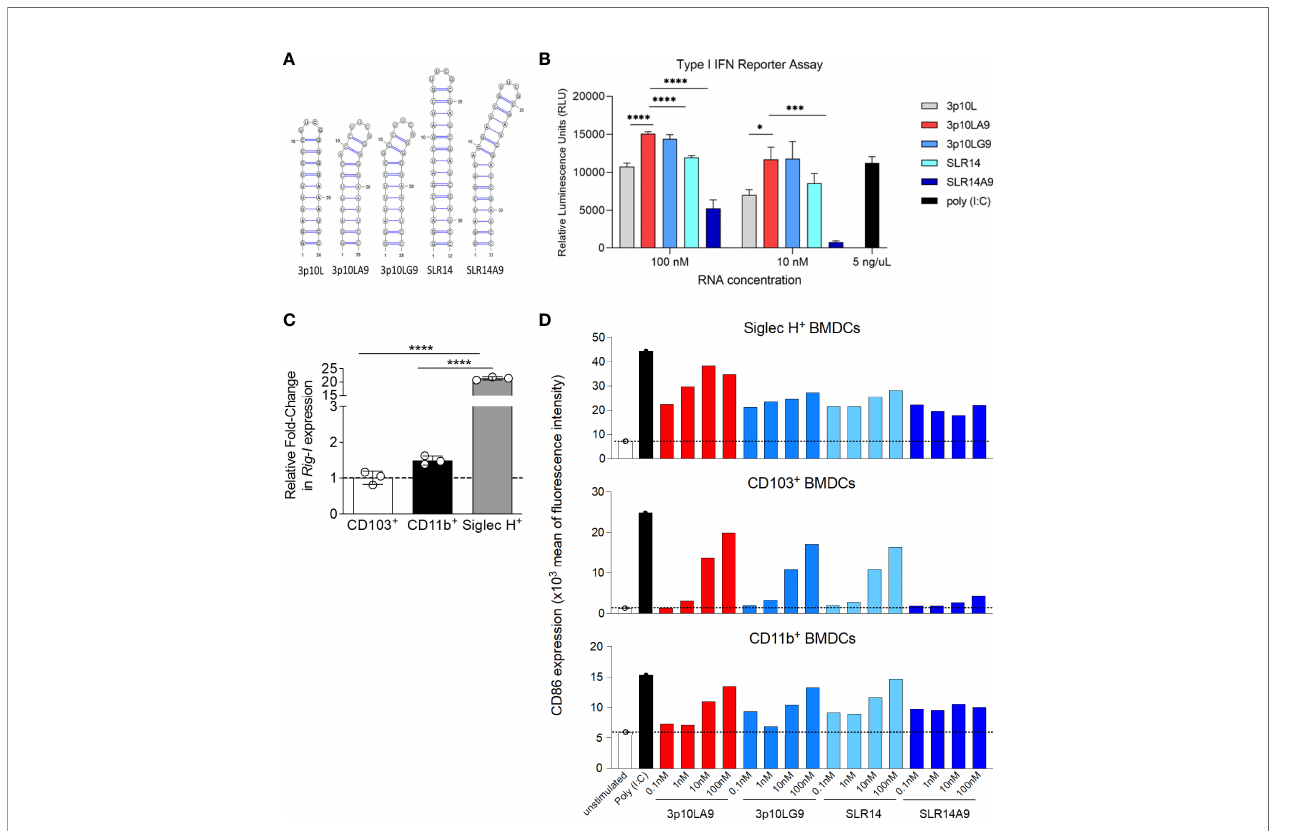
FIGURE 1 | BM-derived DC maturation is induced by dsRNA hairpins (A) Sequence and secondary structure of the dsRNA hairpins used in this study. (B) Type I IFN related relative luminescence units (RLU) of A549-Dual ™ supernatant at 24h post dsRNA hairpin treatment. Poly (I:C) treatment (5 ng/µL) as positive control (n = 3). * P < 0.05; *** P <0.001;**** P < 0.0001; two-tailed t-Student ’ s Test. These data are representative of three independent experiments. (C) Quantitative PCR analysis of RIG-I expression in BM-derived sorted pDCs, CD103 + and CD11b + DCs. Data represent the mean ± SEM (n = 3). (D) BMDCs were stimulated with 4 different concentrations (0.1 – 100 nM) of dsRNA hairpins (3p10LA9, 3p10LG9, SLR14 and SLR14 A9) and tested 24 h later for CD86 expression by fl ow cytometry. BM cells were fi rst gated on Siglec H + cells to visualize pDCs, the remaining cells were gated on CD11c + MHC II + double positive cells and separated into CD11b and CD103 to delineate two different DC subsets. Unstimulated and Poly I:C (5 m g/ml) stimulated cells were included as negative and positive controls, respectively. Each bar represents one value and the experiment was independently repeated one more